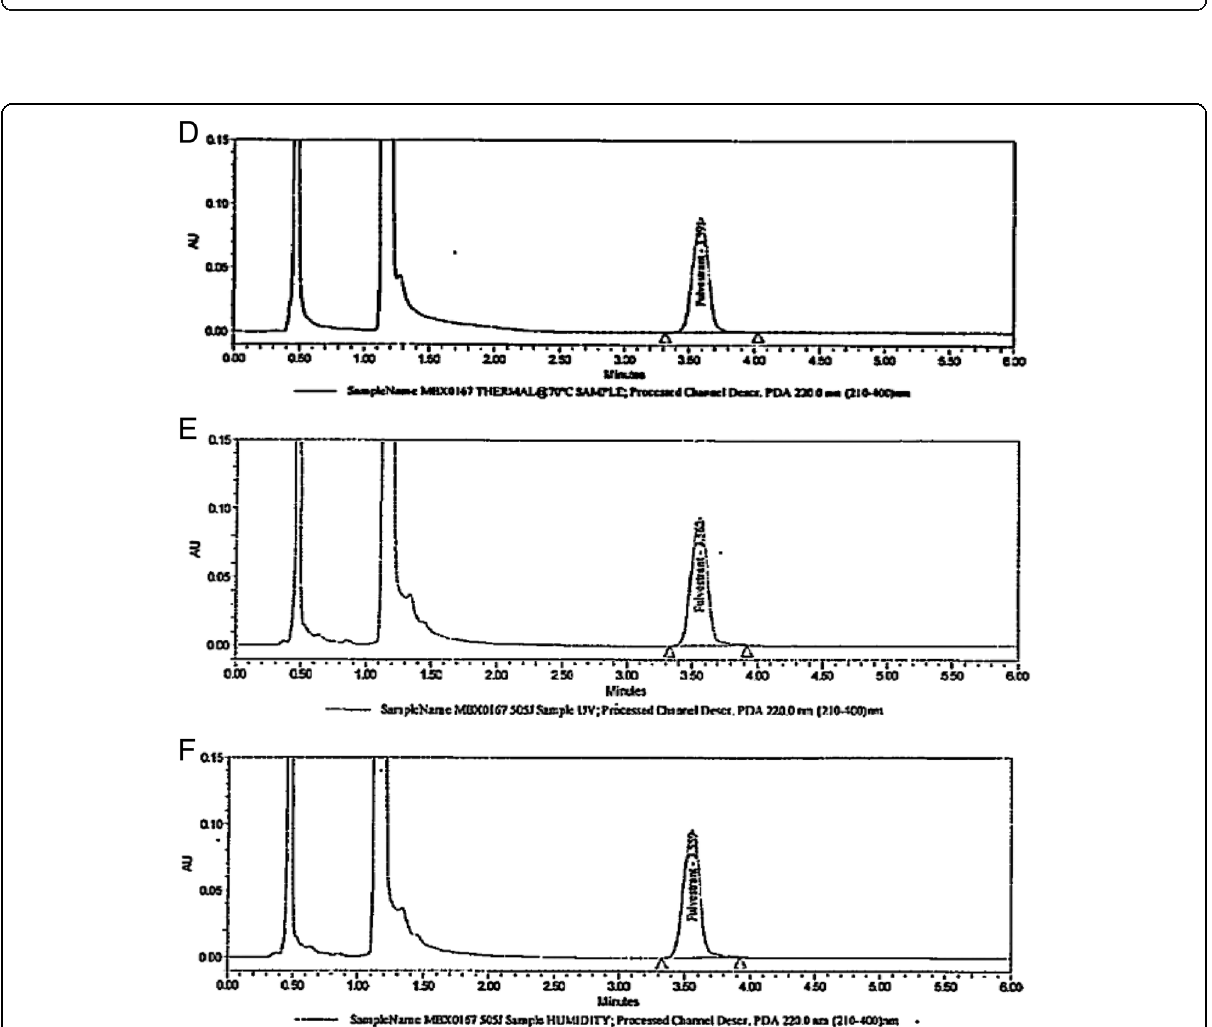
Fig. 3 d Thermal stressed sample chromatograms (100 μ g mL − 1 ). e Photo stability stressed sample chromatograms (100 μ g mL − 1 ). f Humidity stressed sample chromatograms (100 μ g mL − 1